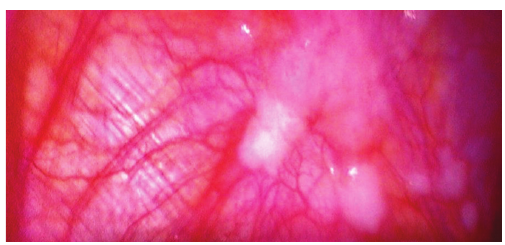
Figure 2: Diagnostic laparoscopy showing peritoneal metastasis on